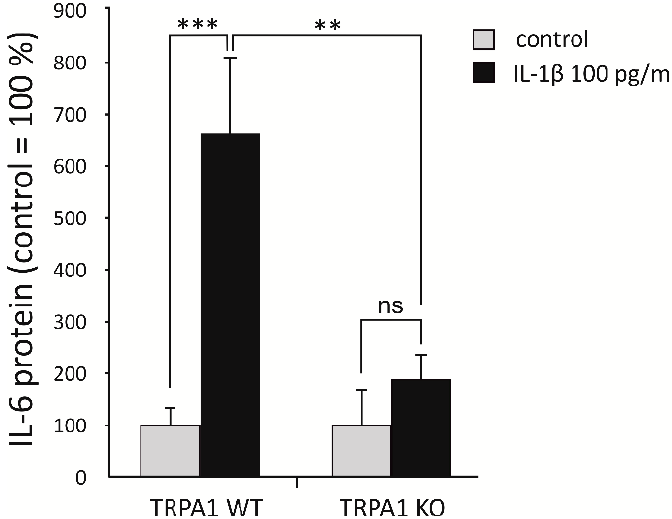
Figure 2. IL-1 β -induced production of IL-6 in cartilage is attenuated by genetic deletion of TRPA1. Cartilage samples (from femoral heads) were obtained from six TRPA1 deficient (KO) mice and six corresponding wild-type (WT) mice. The cartilage pieces were cultured in the presence of IL-1 β (100 pg/mL) or without stimulation for 42 h, after which the culture medium was collected, and IL-6 was measured by immunoassay. The results are expressed as mean + SEM, n = 6. One-way ANOVA followed by Bonferroni post-test was performed; ** p < 0.01, *** p < 0.001, ns: not signifi- cant. (Adapted from the doctoral dissertation of the first author [28]).